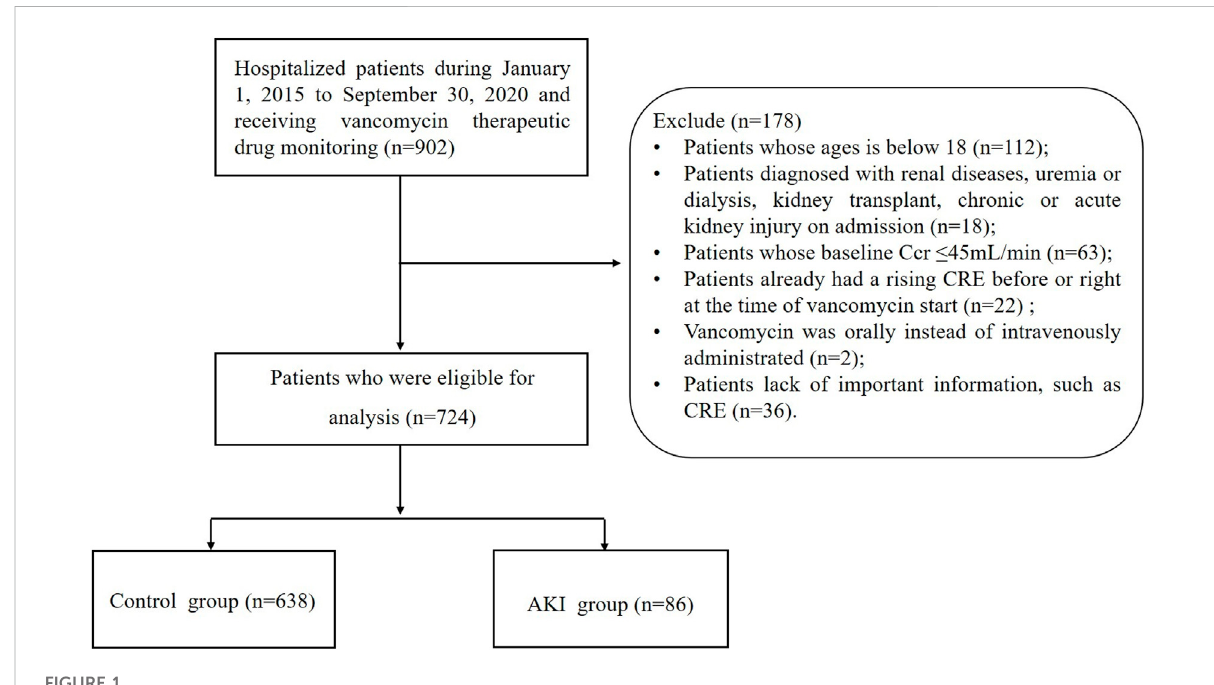
FIGURE 1 Flowing chart of population